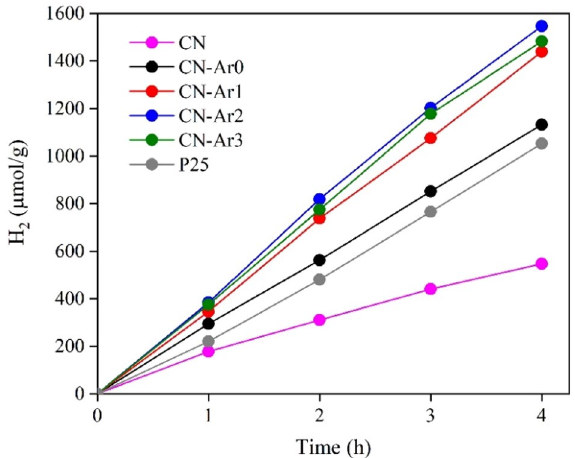
Figure 11. Time dependence of hydrogen yields during the photocatalytic hydrogen generation from water– methanol mixture in the presence of CN, CN-Ar materials and TiO 2 at irradiation of 254 nm.